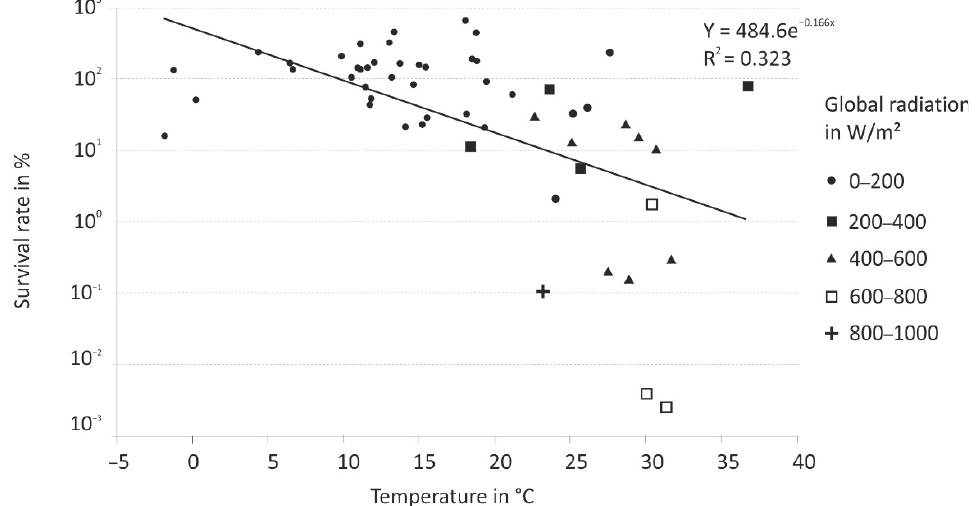
Figure 6. Survival rates of Staphylococcus xylosus after 12 min in the airborne state as a function of temperature and the influence of global radiation ( n = 54).